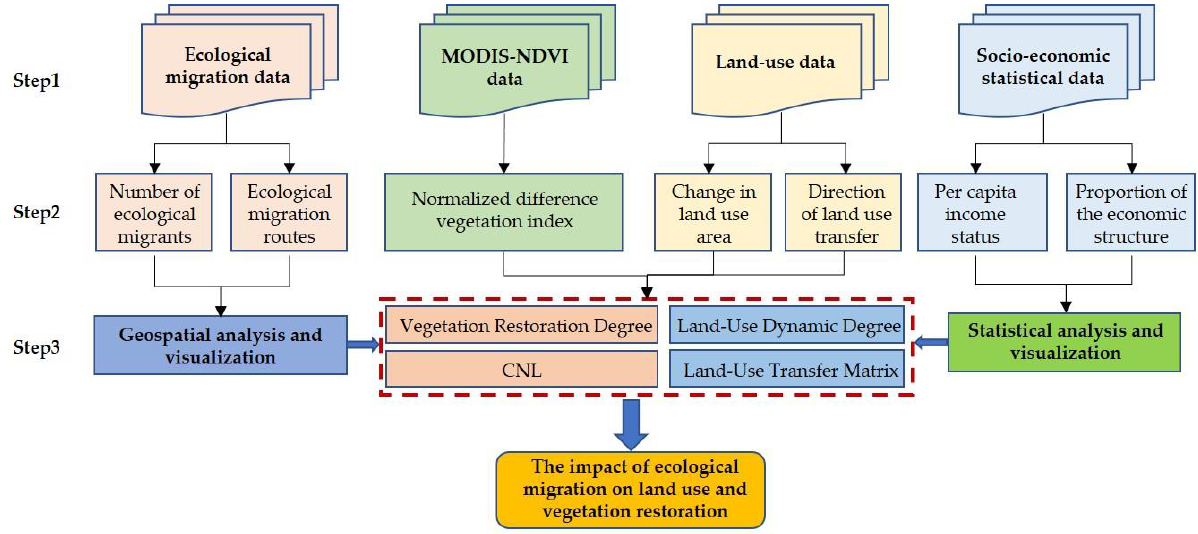
Figure 1. The research process of this study. Note: CNL = contribution to NVDI increment by land use.